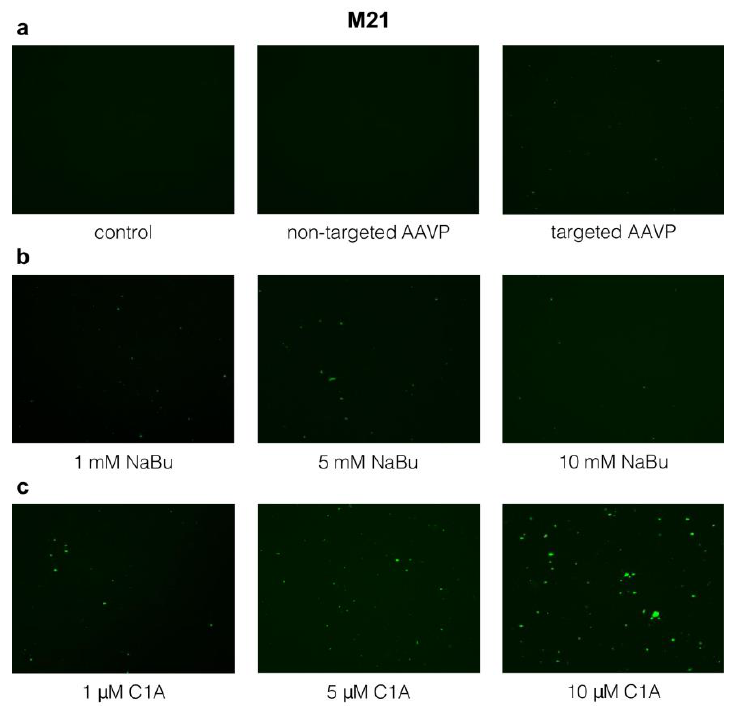
Figure 3. Gene delivery by RGD4C-AAVP in vitro into M21 cells 6 days post vector transduction with and without adjuvants. ( a ) Control (untreated cells) and non-targeted AAVP did not show any GFP expression, while targeted AAVP showed some transgene expression. ( b ) Sodium butyrate (NaBu) increased transgene expression in M21 cells. ( c ) C1A increased transgene expression in M21 in a dose dependent manner and more profoundly than the sodium butyrate. The experiment was repeated twice in triplicates and the results shown are representative of one experiment. Images are shown at 20× magnification.